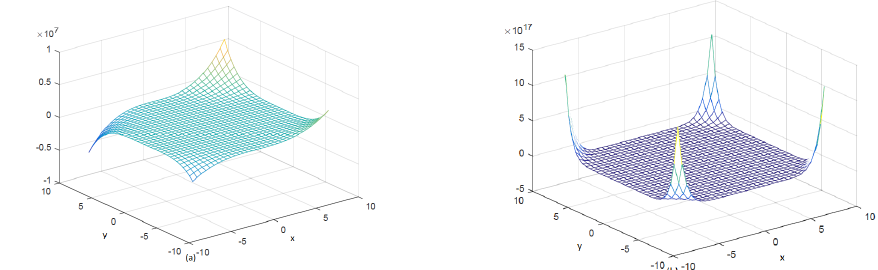
Figure 2: Plotting of (a) M-polynomial and (b) NM-polynomial of amathaspi- ramide